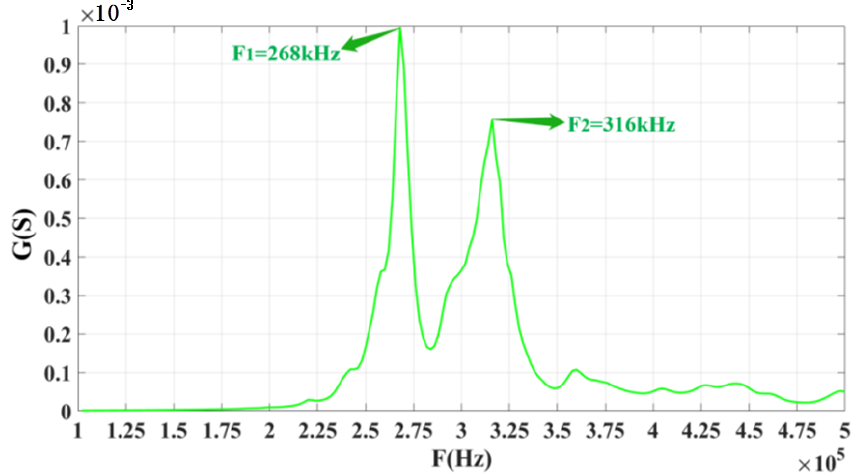
Figure 4. Conductance curves obtained from the simulation of the model.